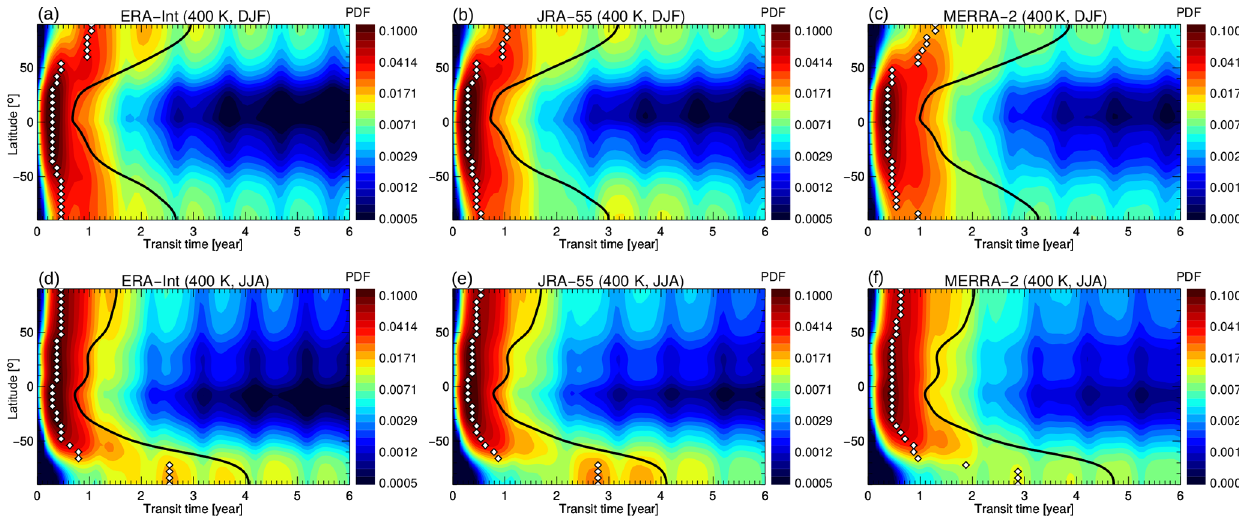
Figure 3. Age spectrum (as transit time probability density function (PDF) in month − 1 ) at 400K for December–February (a, b, c) and June–August (d, e, f) for ERA-Interim (a, d) , JRA-55 (b, e) and MERRA-2 (c, f) . Climatological values for 1989–2015 are shown. The black line shows the mean age, and the white diamonds show the modal age.